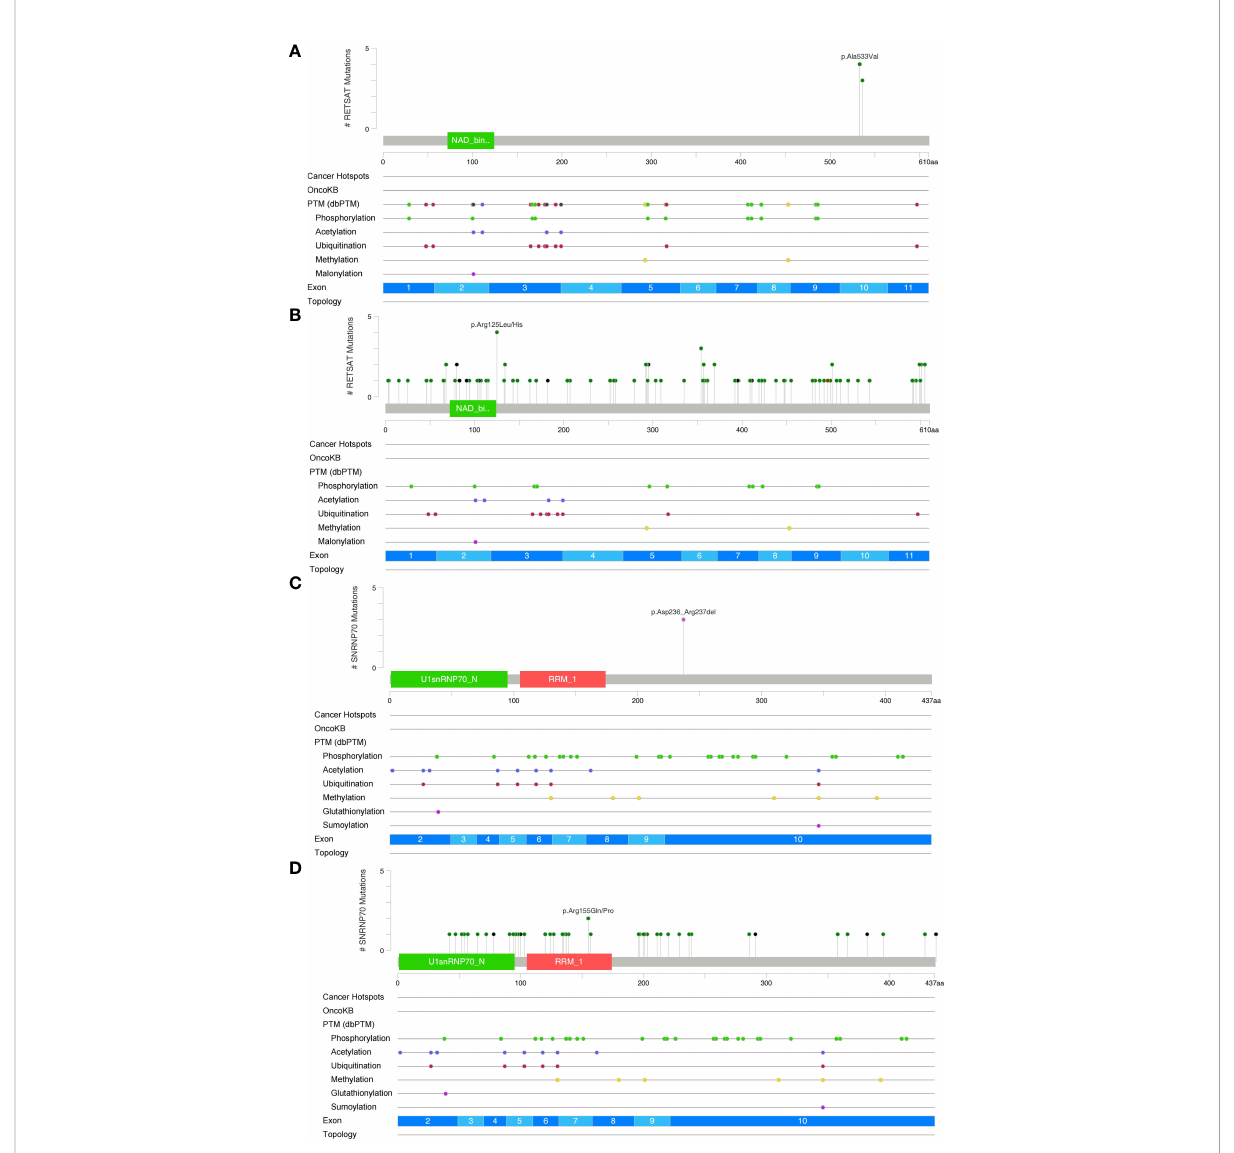
FIGURE 3 Lollipop plot illustrating RETSAT mutations in the GI-NKTCL (A) and TCGA-Pancancer (B) cohorts. Lollipop plot illustrating SNRNP70 mutations in the GI-NKTCL (C) and TCGA-Pancancer (D)